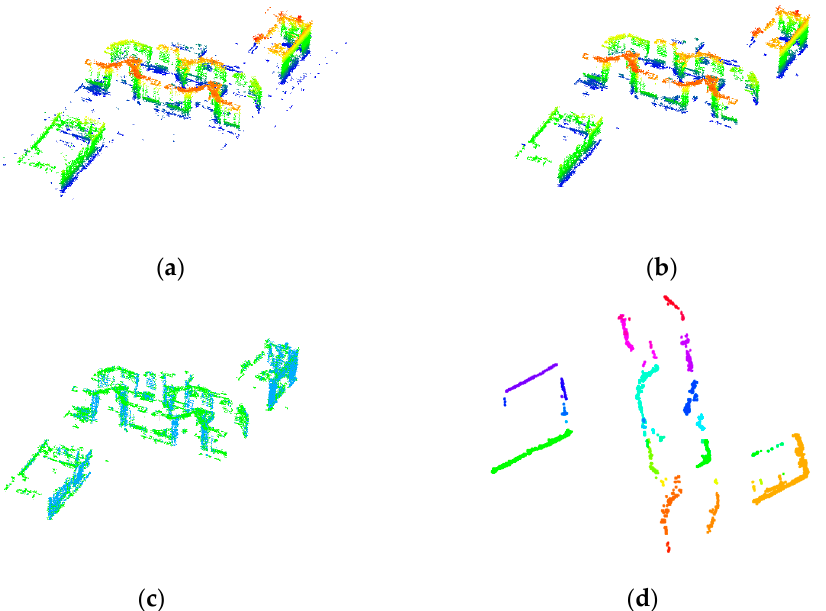
Figure 4. Results of filtering and facade point extraction: ( a ) original point cloud; ( b ) point cloud based on statistical filtering; ( c ) building points extracted according to DoPP projection, with blue indicating building facade points and green indicating building planes or other structural points; ( d ) results of density clustering.